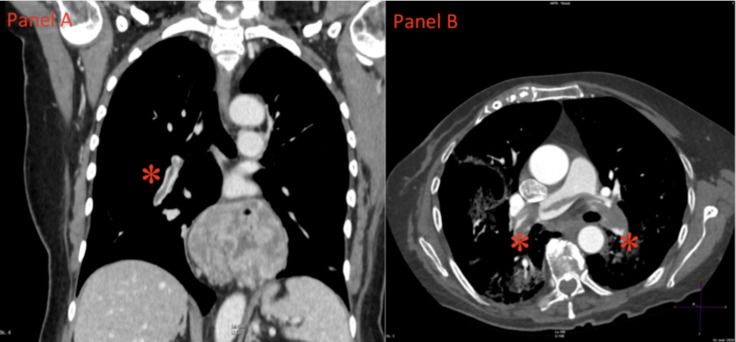
CTPA images of pulmonary embolism.(A) Coronal Computer Tomography Pulmonary Angiography (CTPA) image shows a partial intraluminal filling defect within right interlobar artery (asterisk). (B) Axial CTPA image shows a massive intraluminal filling defect of both main pulmonary arteries (asterisks).